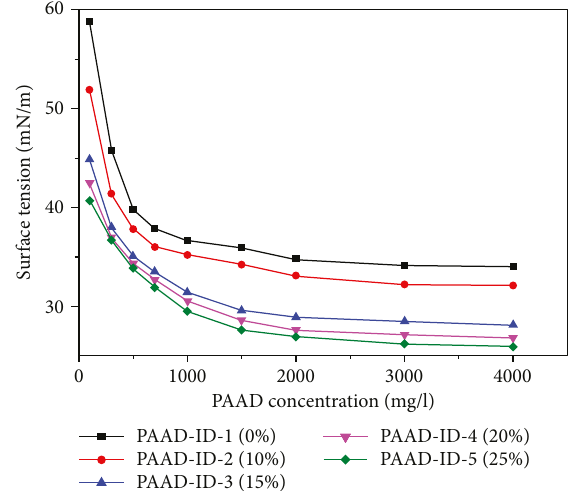
Figure 7: Variation of the surface tension with concentration of PAAD in water with the NaCl concentration of 1000 mg/l at 25 °